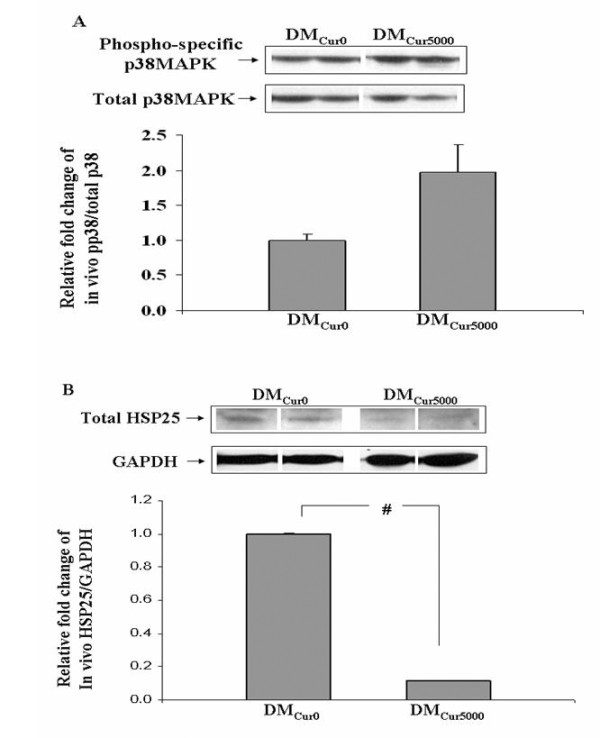
Effects of Curcumin on p38MAPK and total HSP25 on Stz-DM mice. Representative Western blot and quantitative evaluation of phospho-specific p38MAPK (a) and total HSP25 relative to GAPDH (b) in renal cortex of DMCur0 and DMCur5,000 mice. *P < 0.05; #P < 0.01.